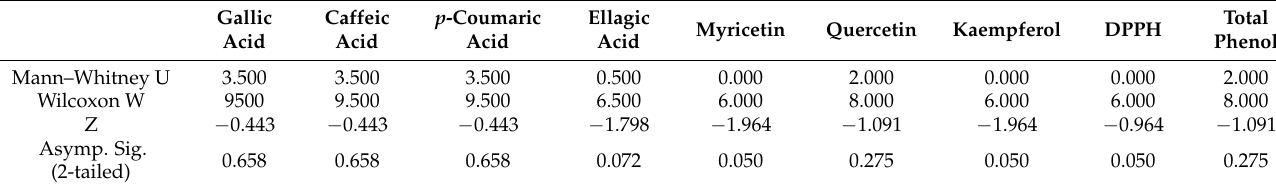
Table 5. Mann–Whitney U test between